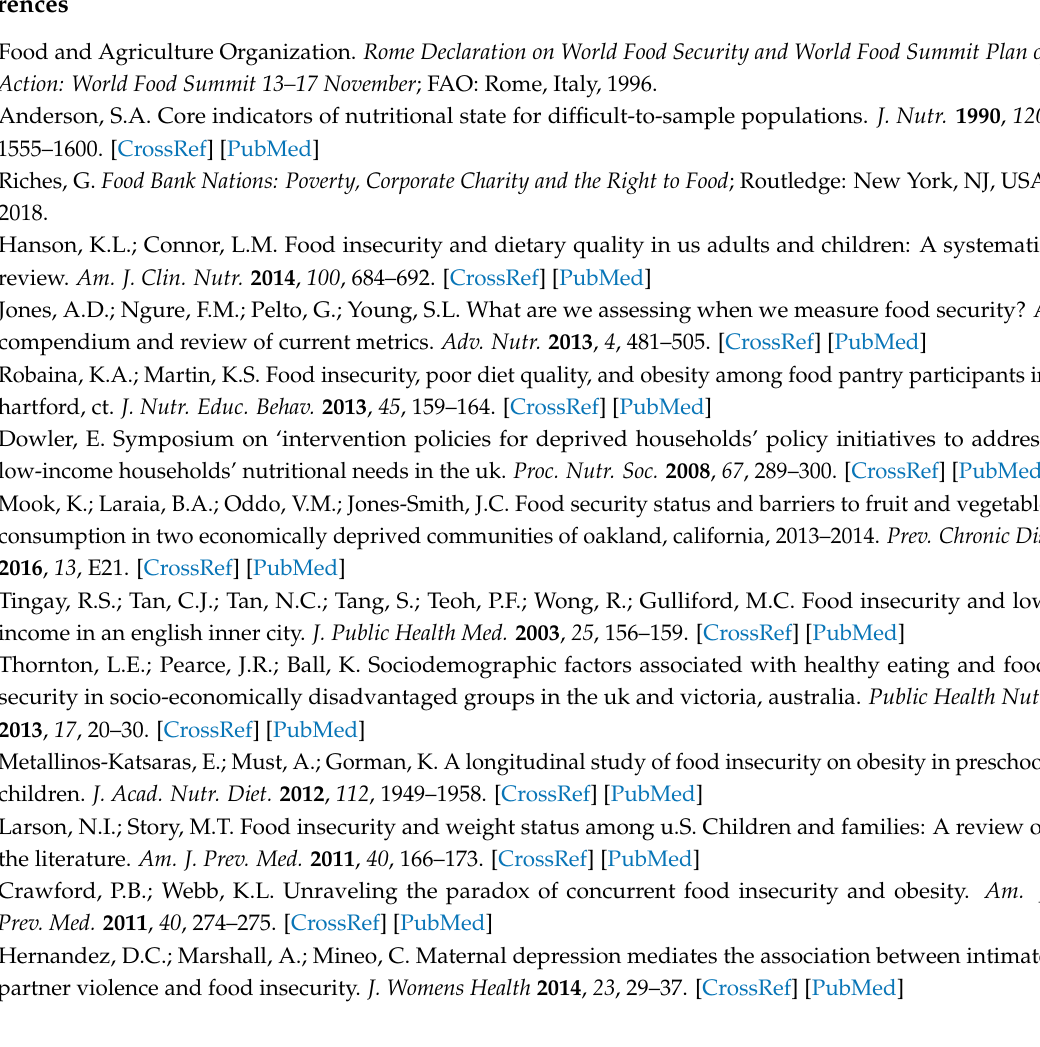
Table S1: Illustrating the full model of propensity scoring for incomes above and below